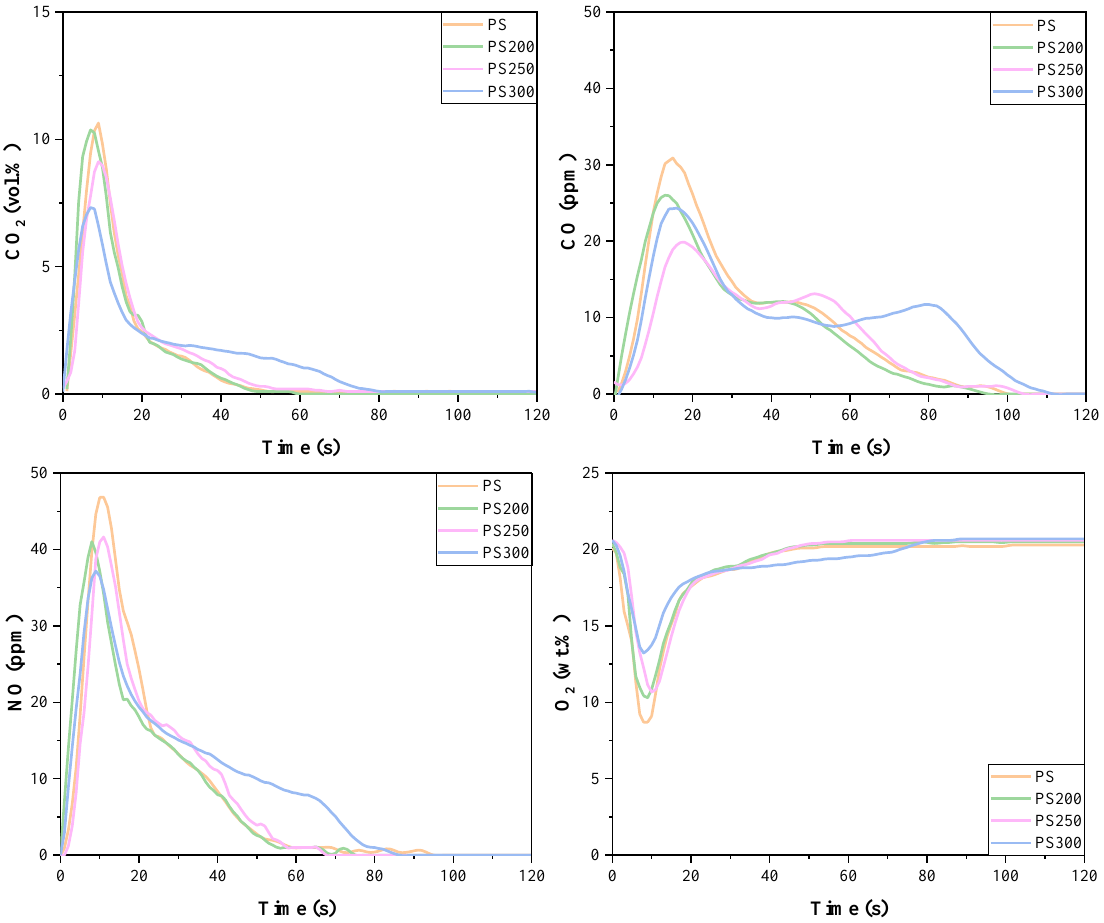
Figure 5. CO 2 , CO and NO emissions and O 2 consumption of isothermal combustion.